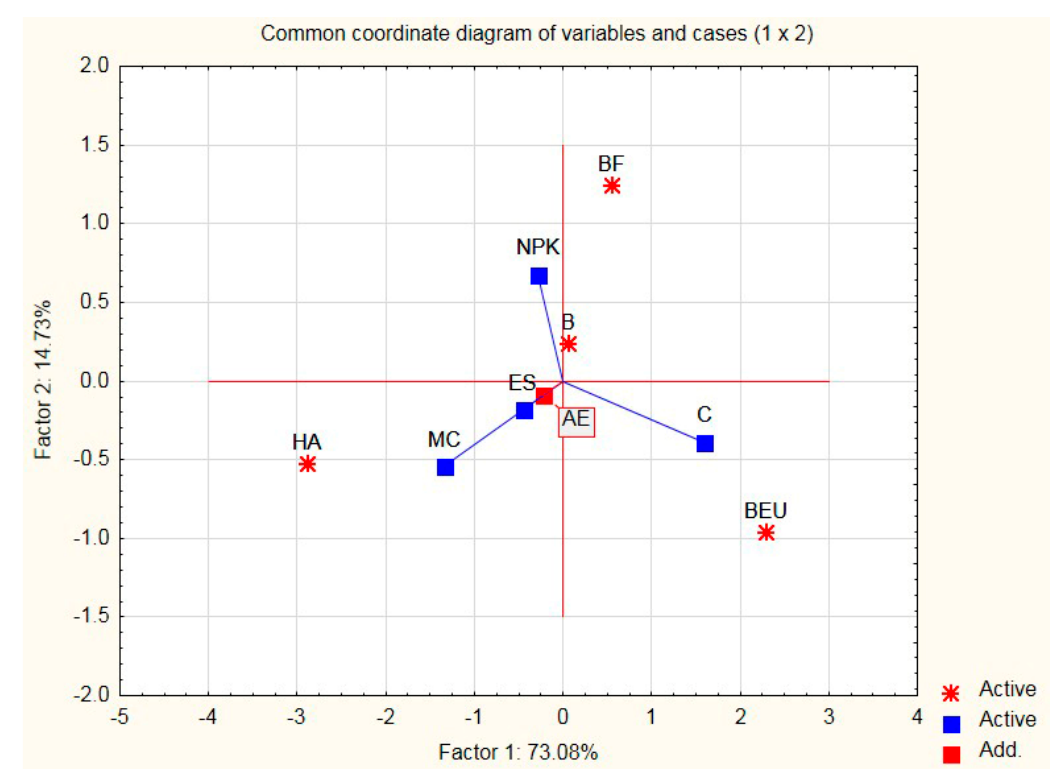
Figure 5. Projection of cases on the plane of factors (integrated). Table 1. Characteristics of organic silicate mass fillers for technical and economic analysis in meas- urable and non-measurable values. median